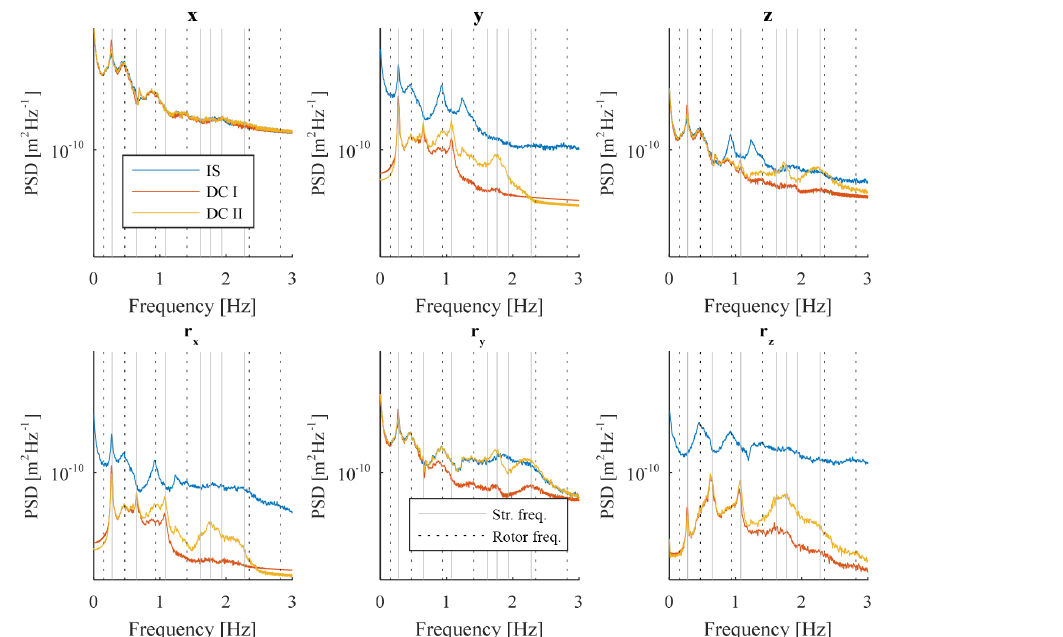
Figure 8. PSD for tower top displacements of DC I and DC II with a wind speed of 8ms − 1 . Continuous vertical lines show structural eigenfrequencies, while vertical dotted lines show rotational frequencies of the rotor.